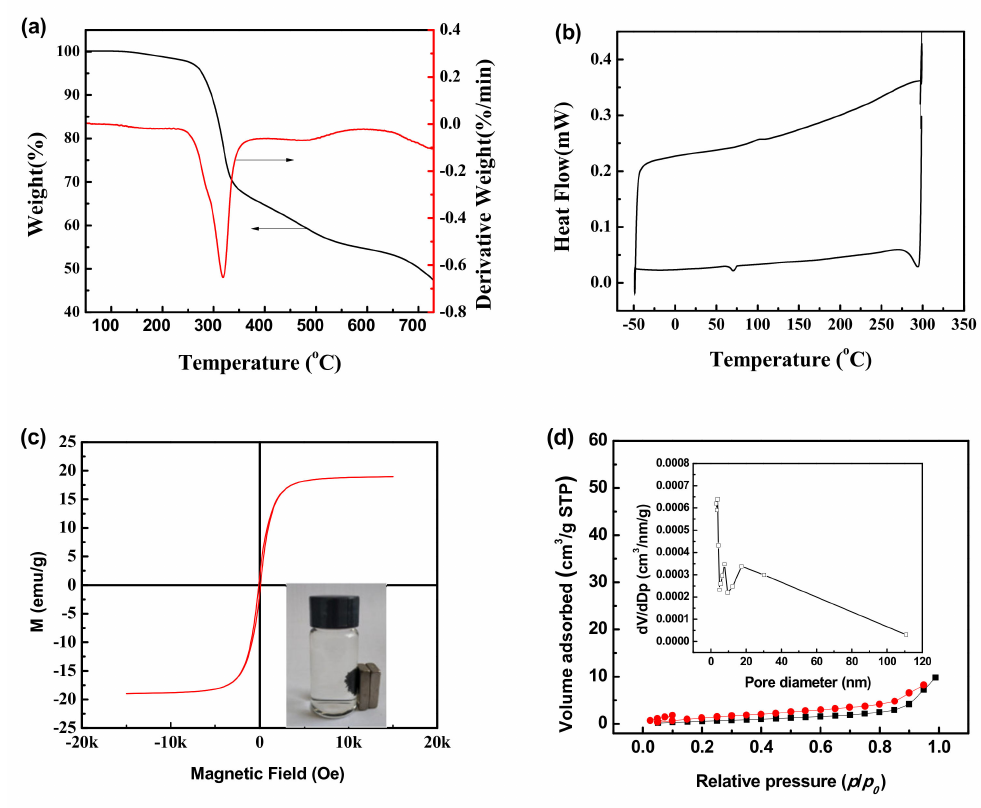
Figure 2. ( a ) TG and ( b ) DSC curves of the XMPC; ( c ) magnetization curves of the XMMCP; ( d ) N 2 adsorption–desorption isotherm of the XMPC. Inset: BJH pore size distribution of the